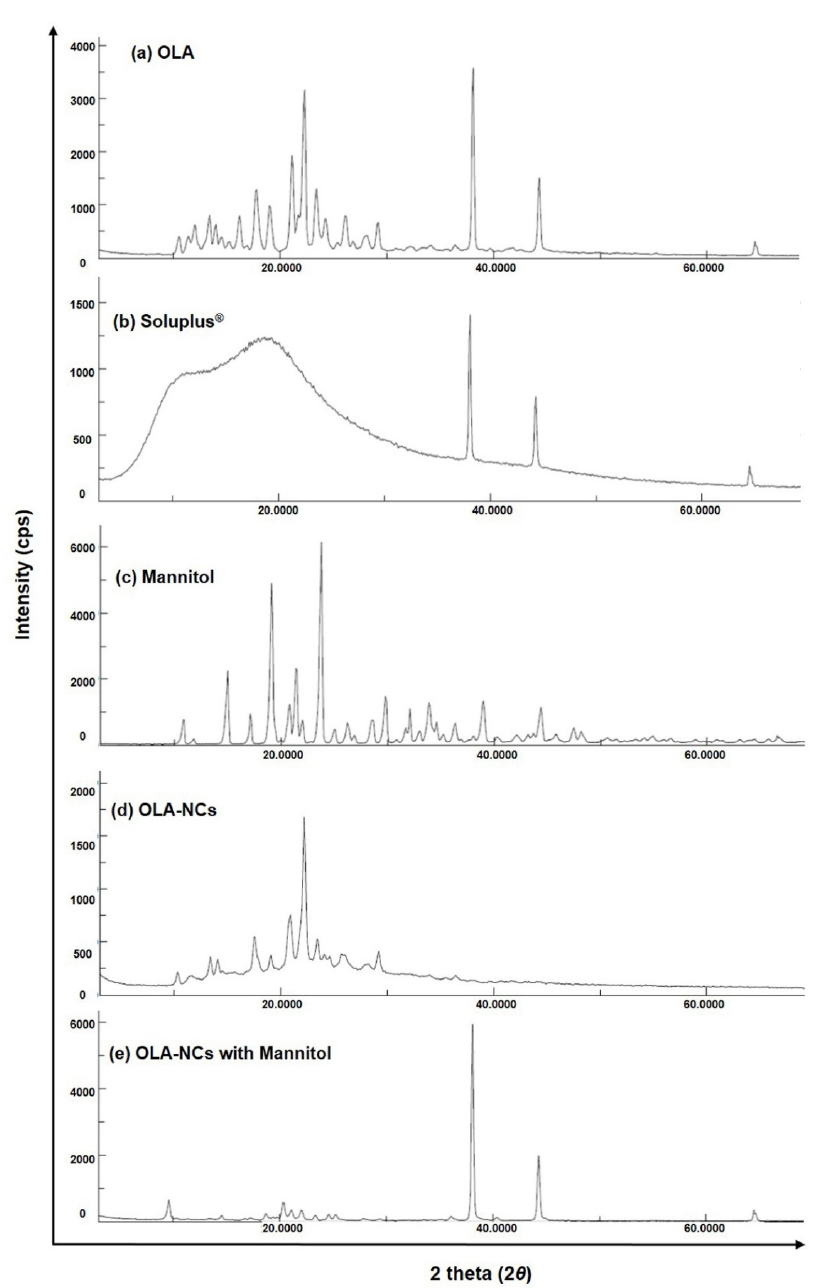
Figure 5. XRD diffractograms of pure OLA ( a ); Soluplus ® ( b ); mannitol ( c ); lyophilized OLA-NCs-2 ( d ) and lyophilized OLA-NCs-2 with mannitol ( e ).